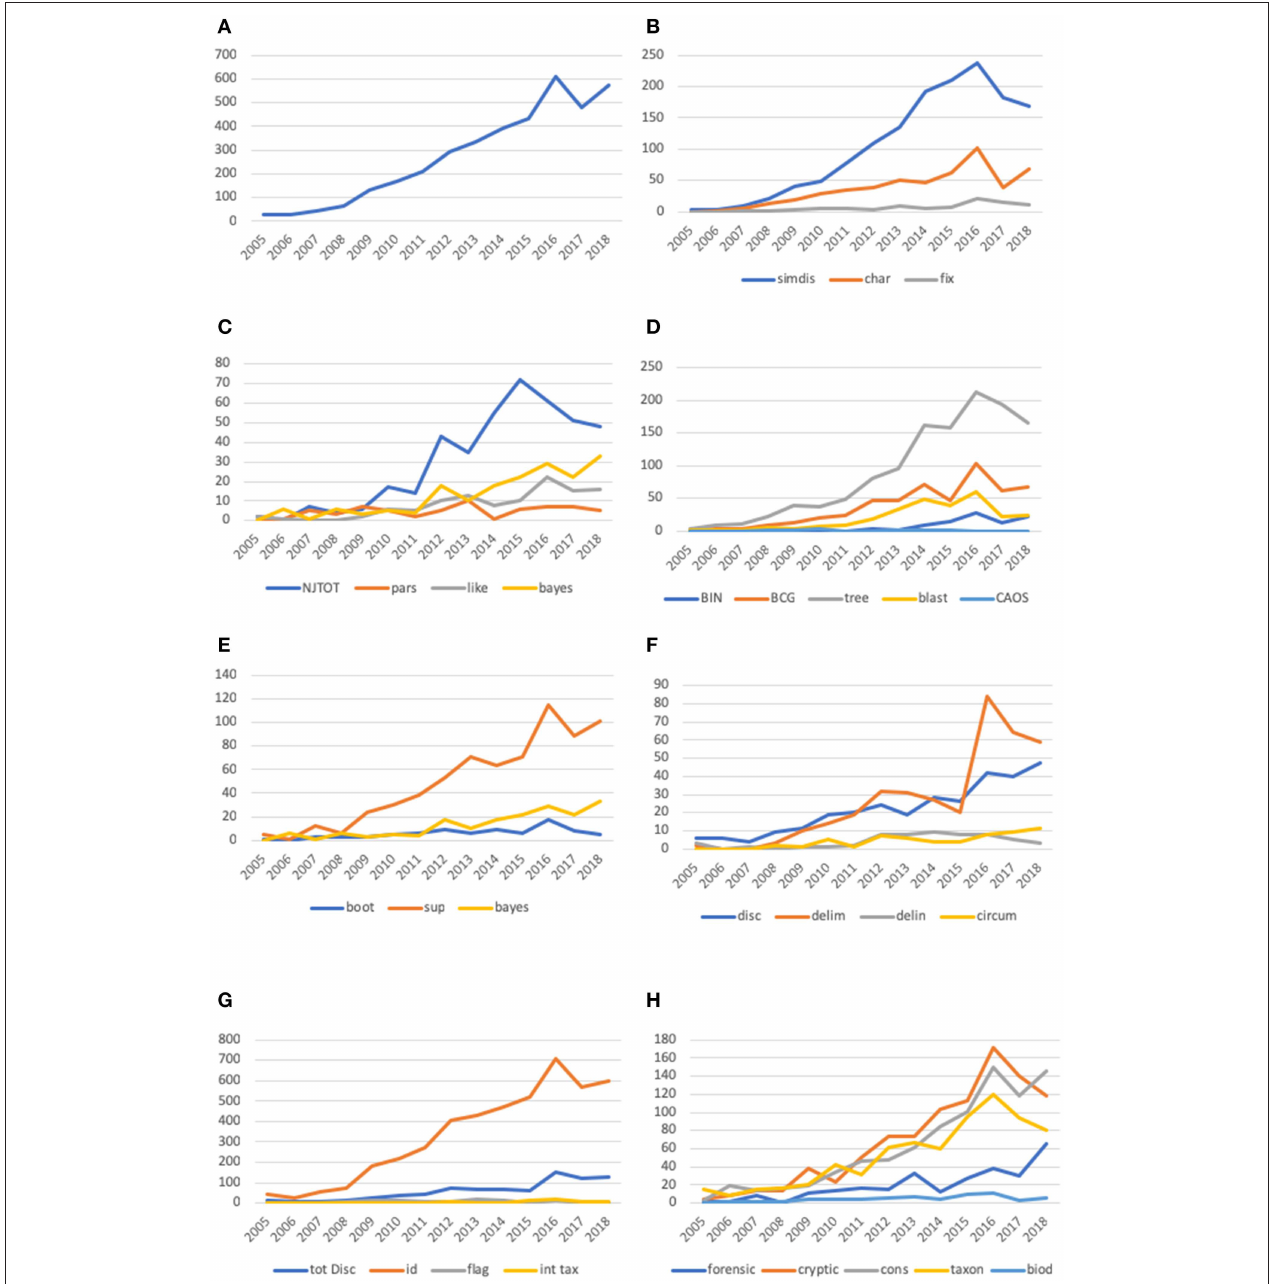
FIGURE 1 | Line plots of number of “hits” for keywords in the DNA barcode vocabulary subcategories established in the text. In all graphs the number of citations is given on the Y-axis and year is given on the X-axis. We also computed relative percentage of citations per year and these results are shown in Supplemental Figure 1 . (A) Graph of the occurrence of scientific papers with the search word “DNA barcoding” in the title from 2003 to 2018. The “blip” in number of papers in 2016 that disrupts an otherwise smooth increase in number of papers by year might represent an increase in reports for the several international meetings that occurred in 2015. (B) The results of this analysis compare character based approaches to similarity/distance approaches. For this analysis we also use fixation as a character based term and show its usage in the graph. Search terms: “similarity” and “distance” combined into “simdis” and “character” and “fixation” combined into “char.” We show the usage of “fixation” alone to demonstrate that this term is rarely used. (C) The results of this analysis compare the three major criteria for phylogenetic analysis—distance, parsimony and likelihood. Search terms: “NJ” and “neighbor joining” combined into “NJTOT,” “parsimony” listed as “pars,” likelihood listed as “like.” Bayesian phylogenetic inference methods have also been used and these are listed under “bayes.” (D) This figure shows comparison of the usage of terms that imply an examination of the robustness of the DNA barcode analysis. Such measures of robustness can be metrics such as bootstrap, or posterior probabilities such as in Bayesian phylogenetic inference. We also Search terms: “bootstrap” listed as “boot,” “support” listed as sup, statistic, bayes. (E) The figure